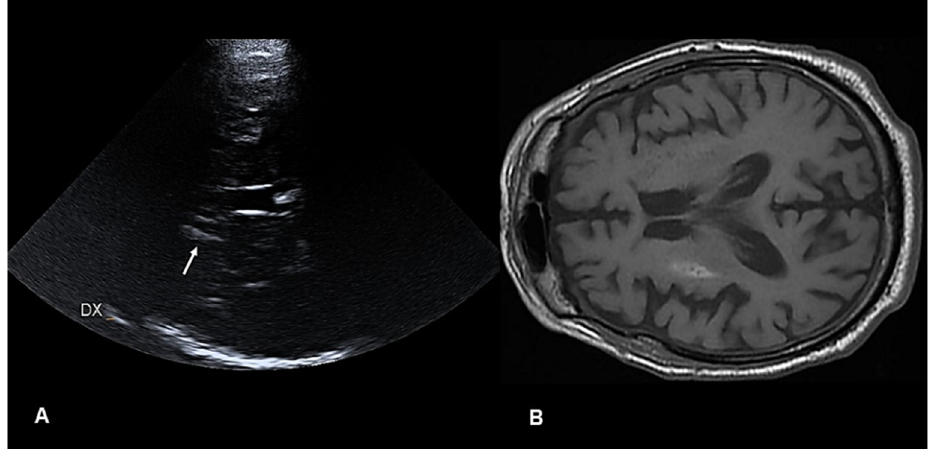
Figure 1. ( A ) ( left panel ) Parenchymal transcranial sonography showing hyperechogenicity in the right (DX) lenticular nucleus ( white arrow ); ( B ) ( right panel ) axial brain magnetic resonance imaging showing a T1-weighted hyperintensity in the right putamen.